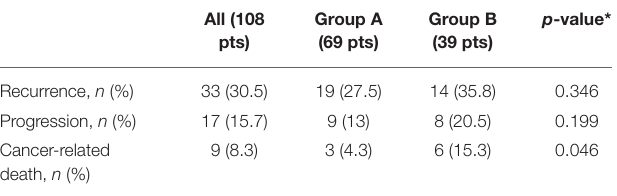
TABLE 3 | Oncological